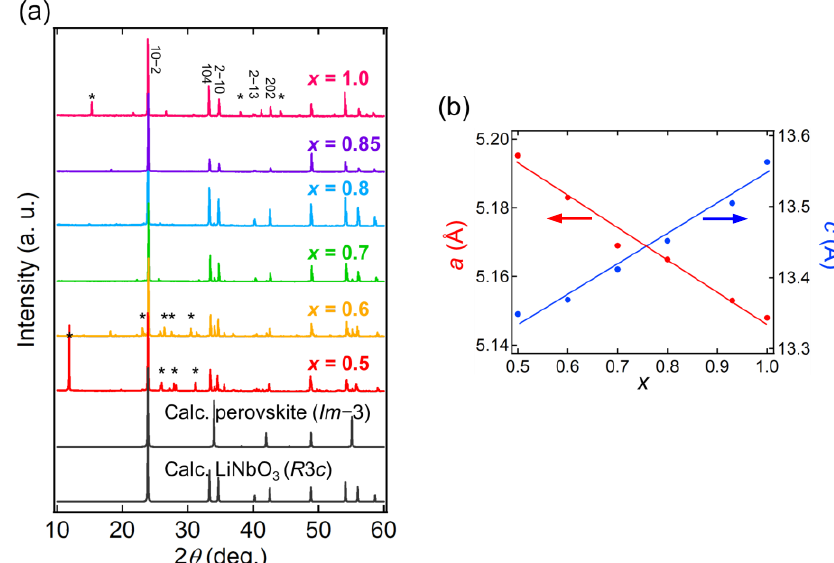
Figure 2. ( a ) XRD patterns of Li x WO 3 (0.5 ≤ x ≤ 1.0) synthesized at 5–8 GPa, demonstrating the formation of the rhombohedral structure. Calculated patterns for the perovskite ( Im −3) and LiNbO 3 ( R 3 c ) structures are shown for comparison. Asterisks denote unreacted starting materials of Li 2 WO 4 , WO 2 , and WO 3 . ( b ) Lattice parameters, a (red) and c (blue), of the rhombohedral Li x WO 3 phase as a function of x . The errors are within the size of the symbols. The solid lines are linear fits to the data.